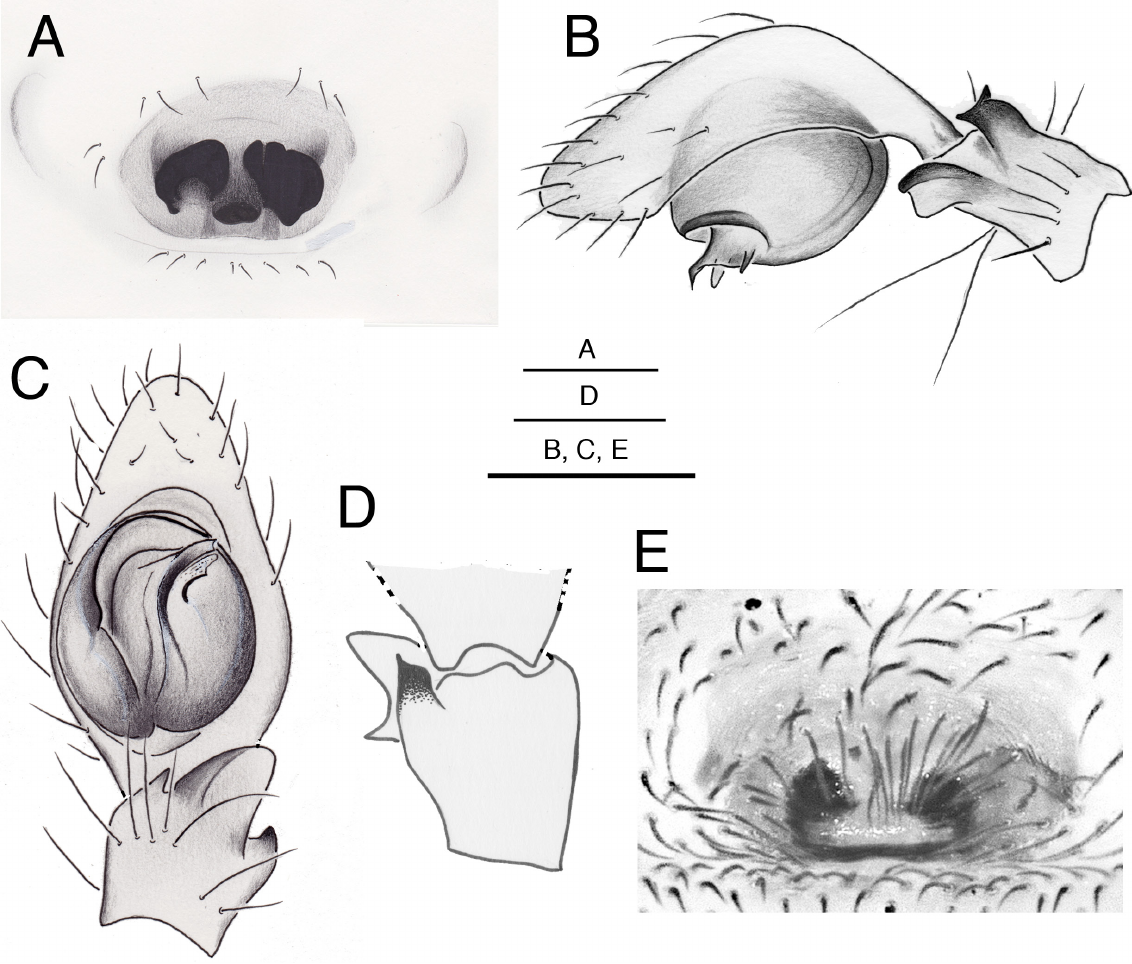
Fig. 8. A . Chumma striata sp. nov., holotype, ♀, epigyne, ventral view. – B–E . Chumma